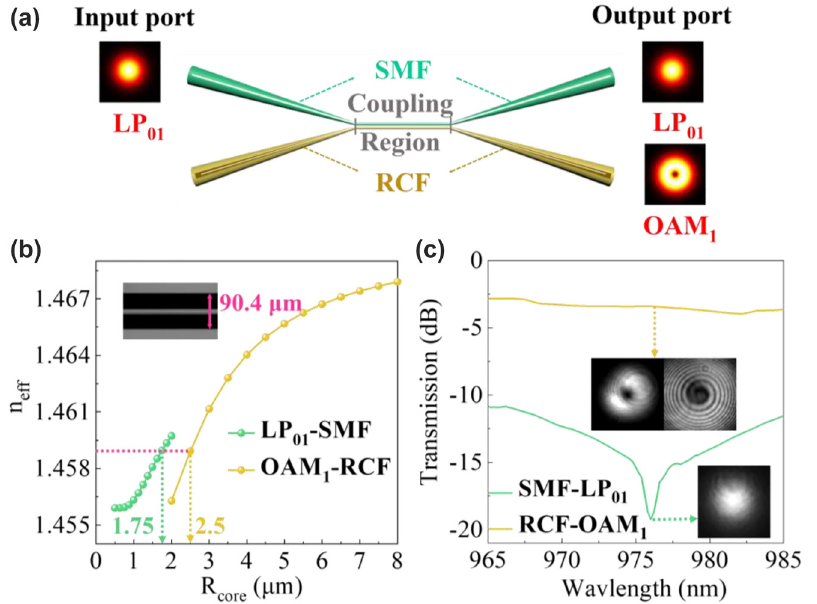
Figure 6: Theoretical modeling and practical performance of MSC. (a) Schematic setup of MSC. (b) Variation of n mode in RCF with the change of fiber core (ring core) radius. In experiment, when the pre-stretched diameter of SMF is 90.4 μ m, SMF and the OAM 1 mode. (c) Transmission spectra of the MSC in 965–985 nm, in which the transmission powers of the OAM MSC can generate the OAM 1 modes are close to − 3 dB and below − 19 dB.